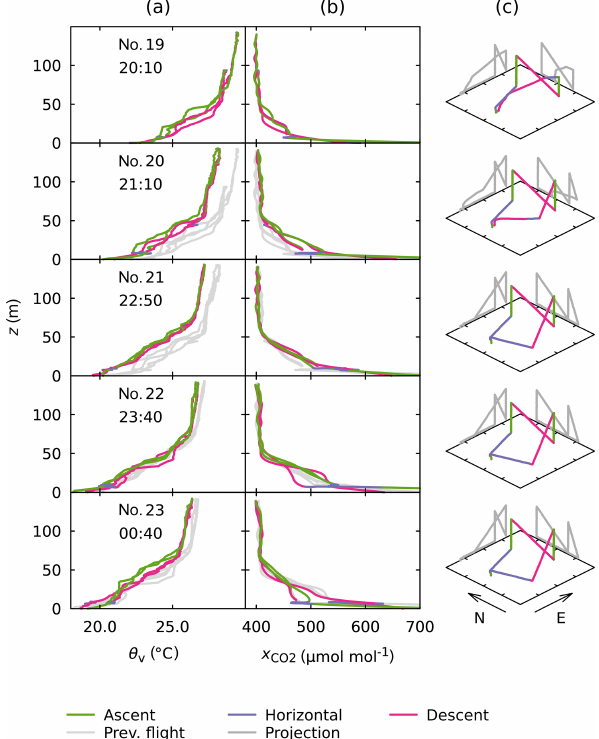
Figure 8. Same as Fig. 7, but for flights 19 through 23 carried out in the night from 9 to 10 July 2016. The axis for virtual potential tem- perature is shifted towards higher temperatures compared to Fig. 7 but covers the same span. All other axes are unchanged. The hori- zontal legs were flown at 10m